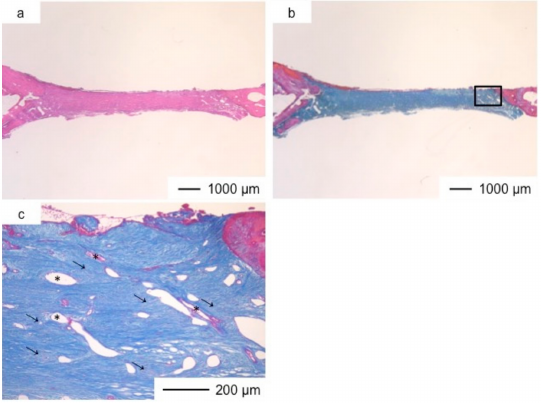
Figure 6. Light microscopic images of ChGCa in cranioplasty three years after implantation, stained by HE ( a ) and AM ( b ); ( c ) Magnification of the inset in ( b ).